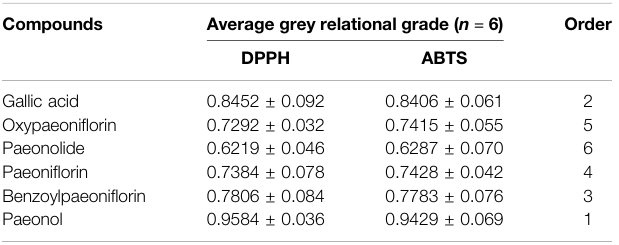
TABLE 2 | Grey relational grade with rank order of six compounds detected in